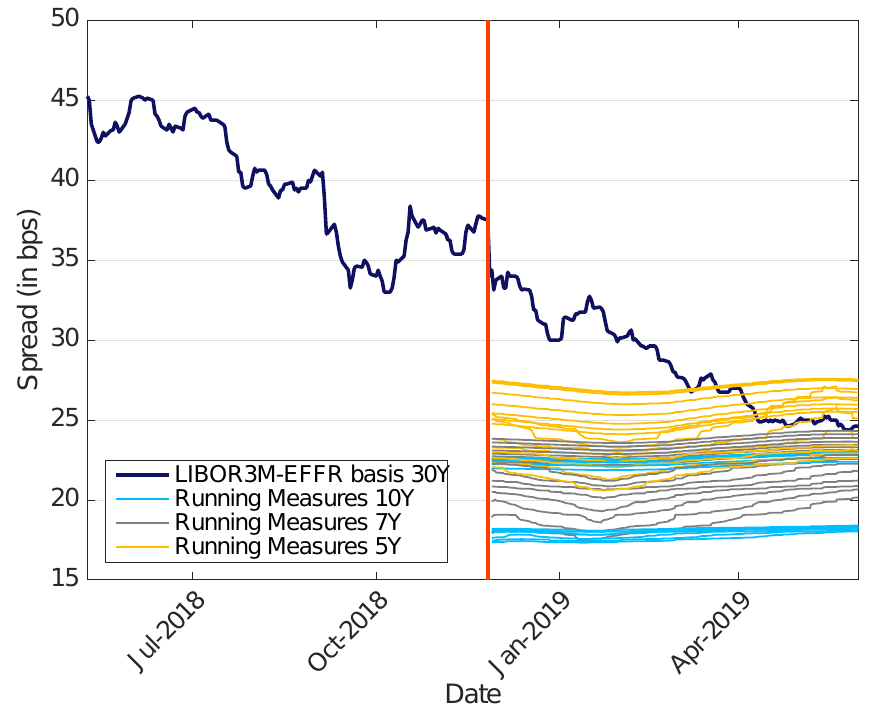
Figure 5. Historical time series for long tenor (30-year) basis swaps USD-LIBOR-3M/EFFR around the ISDA consultation period. The red vertical line is the consultation result date. The different thin lines are the author’s estimates using scenarios with different